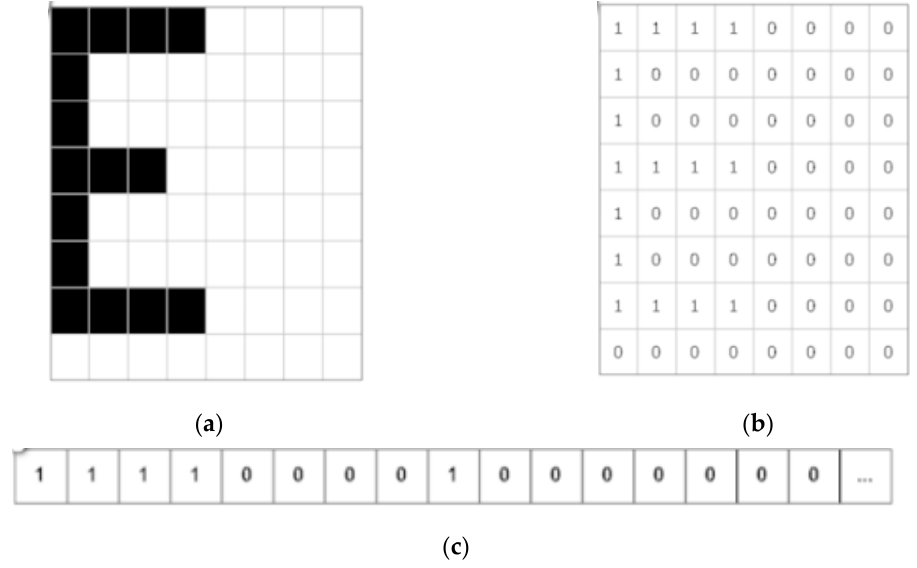
Figure 5. The representation of morphology in three parts. ( a ) The binarized shape. ( b ) A matrix of zeros and ones corresponding to ( a ). ( c ) The matrix. ( b ) The matrix arranged as a vector, which is how MONICOD works internally. This last representation is called a template. MONICOD: a machine vision solution for the validation of expiration codes stamped on the aluminum or tinplate bottom of